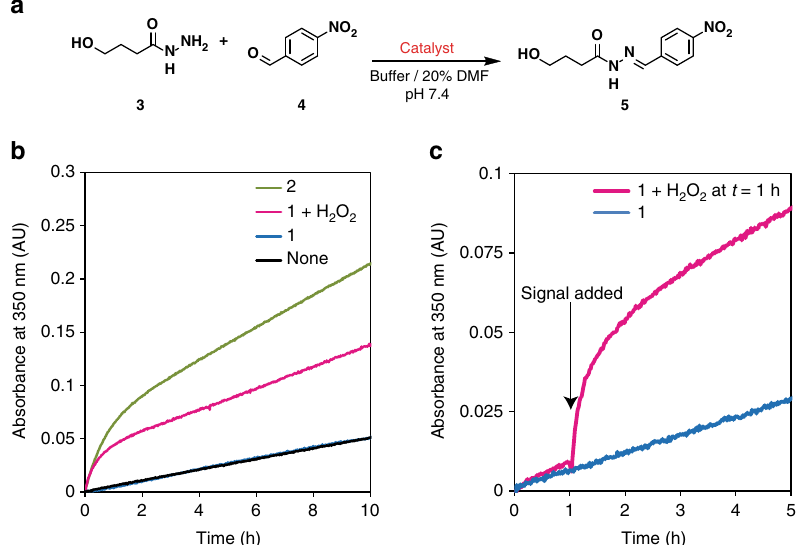
Fig. 2 Control over the rate of hydrazone formation by activation of the catalyst. a Model hydrazone formation reaction, yielding the UV-active probe 5 . Reaction conditions: 0.1 mM hydrazide 3 , 0.5 mM aldehyde 4 , 0.5 mM pro-aniline 1 , 0.5 mM aniline 2 , 2.5 mM (5 equivalents) H 2 O 2 in 20% dimethylformamide (DMF) in phosphate buffer (100 mM, pH 7.4). All experiments were carried out at 25 °C. The 20% DMF was used to ensure that 1 was completely dissolved. The rate of formation of 5 is 10 times higher when using H 2 O 2 -activated pro-aniline 1 than for unactivated pro-aniline 1 . b Formation of 5 over time, without catalyst (black line), in the presence of aniline 2 (green line), in the presence of unactivated pro-aniline 1 (blue line) and in the presence of activated pro-aniline 1 with 5 equivalents of H 2 O 2 (magenta line). c The rate of formation of 5 can be controlled during the process by adding a chemical signal (5 equivalents of H 2 O 2 here after 1 h), liberating the catalyst. Reaction with pro-aniline 1 and subsequent addition of H 2 O 2 (magenta line), reaction with unactivated pro-aniline 1 (blue dashed line). After addition of the chemical signal an immediate response was observed: the reaction rate